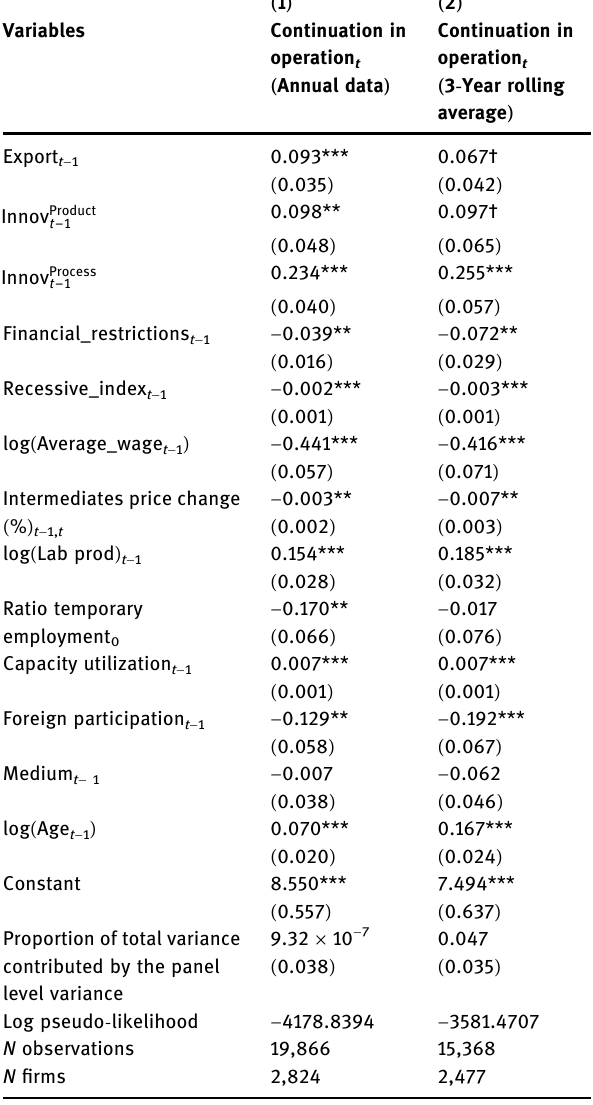
Table A2: Probit estimates for SMEs continuation in